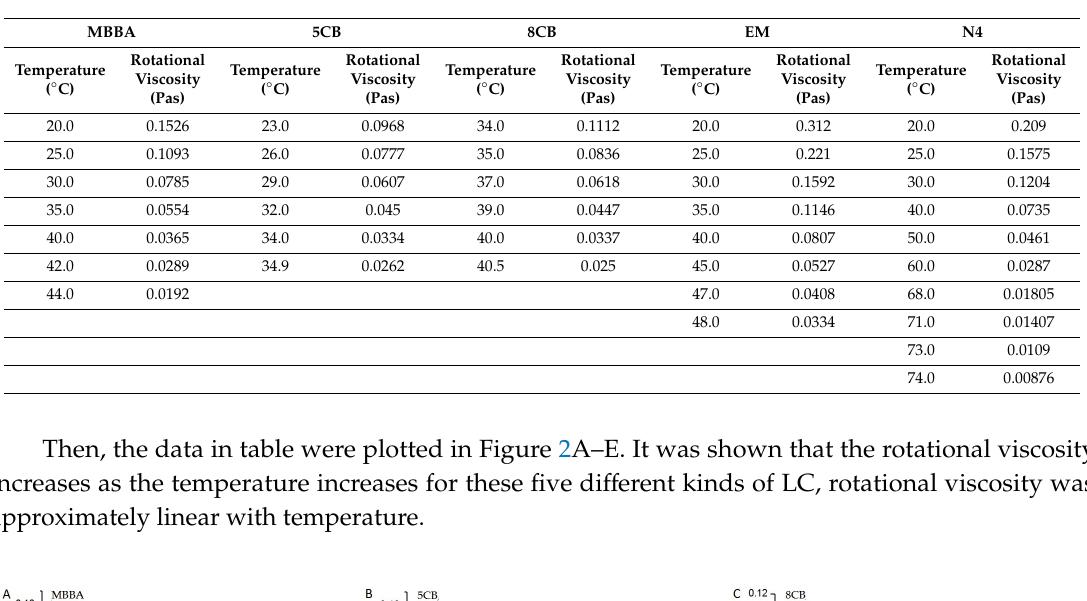
Table 1. Values of rotational viscosity for five di ff erent LCs [25,27].Their clearing points are